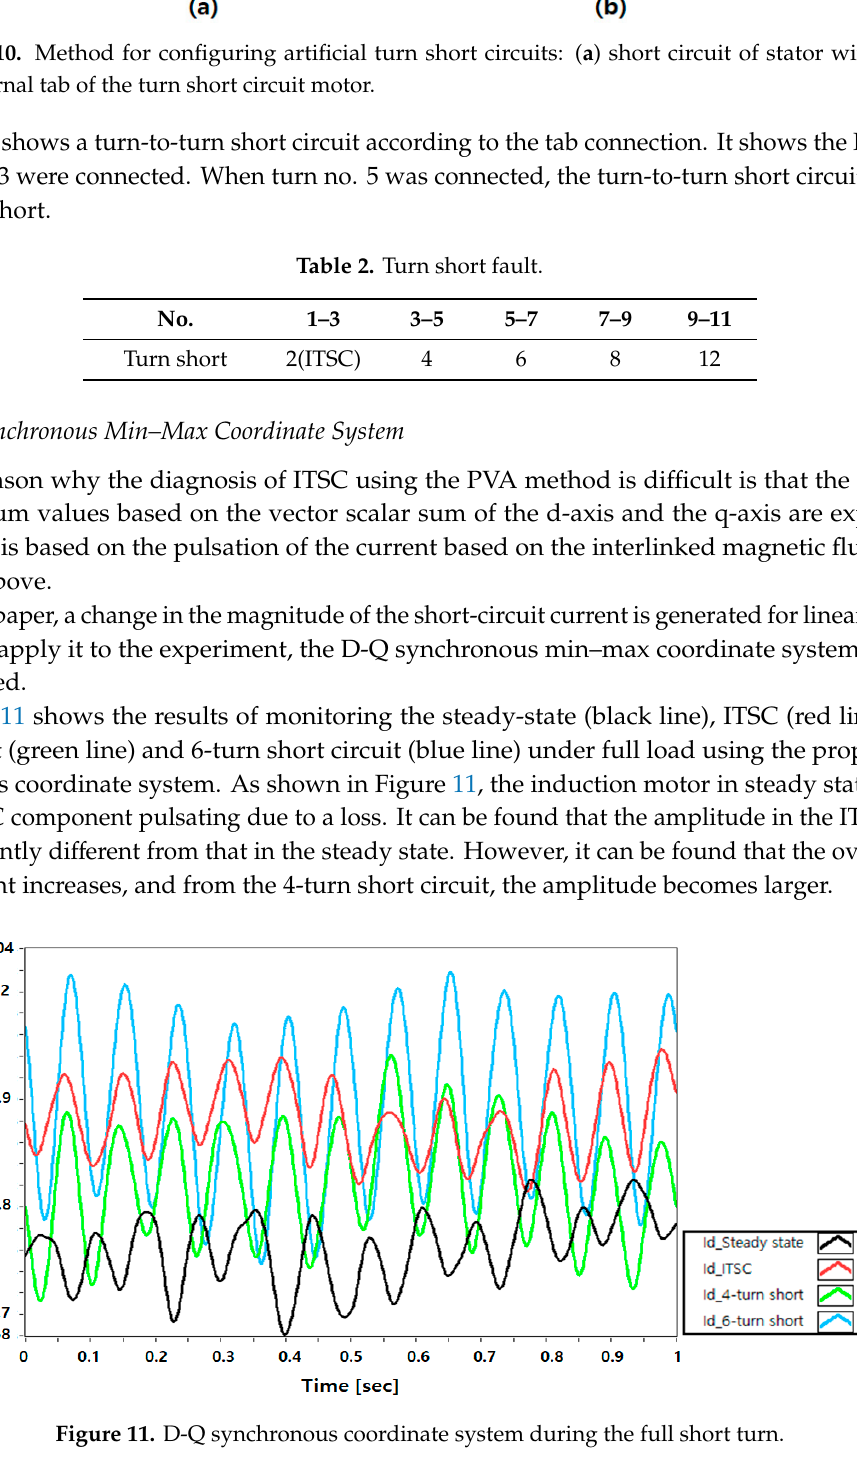
Figure 10. Method for configuring artificial turn short circuits: ( a ) short circuit of stator winding, ( b ) external tab of the turn short circuit motor.